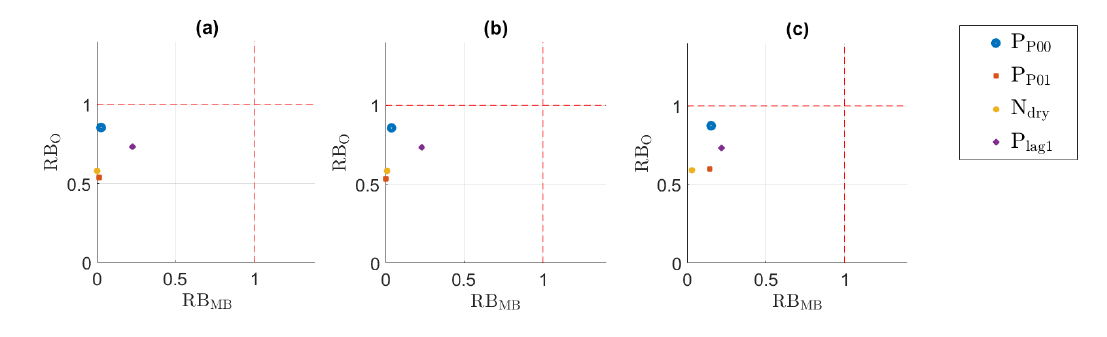
Figure 4. RB MB versus RB O for the precipitation occurrence indices. ( a ) QDM, ( b ) SSR & QDM, ( c ) TDA & QDM.